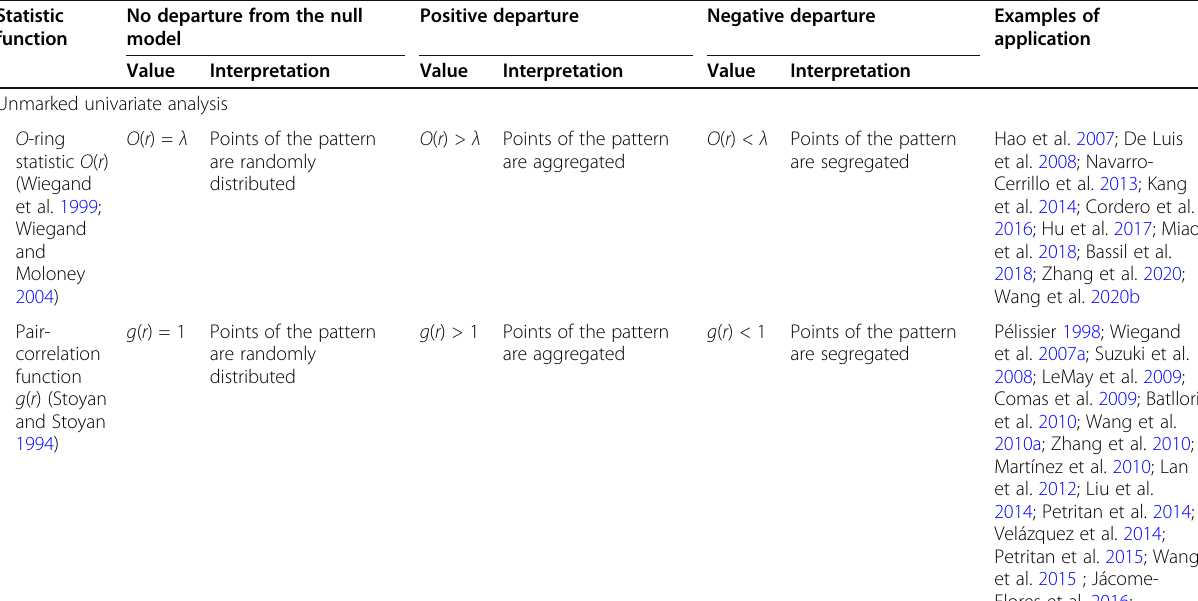
Table 1 Second-order summary statistics commonly used in spatial point-pattern analysis. In the univariate analysis, only one pattern is involved (e.g. one species, one size or age class, one life stage, etc.), while in the bivariate version two patterns (1 and 2) are investigated (e.g. two different species, two size classes, two life stages, etc.). For the mark correlation analysis, the most studied mark is by far tree diameter. In the case of random labelling analysis, the marks usually consist of tree status (e.g. dead vs living). For all analysis types, positive, negative, or absence of departure from the null model simulation envelopes occurs at a given scale